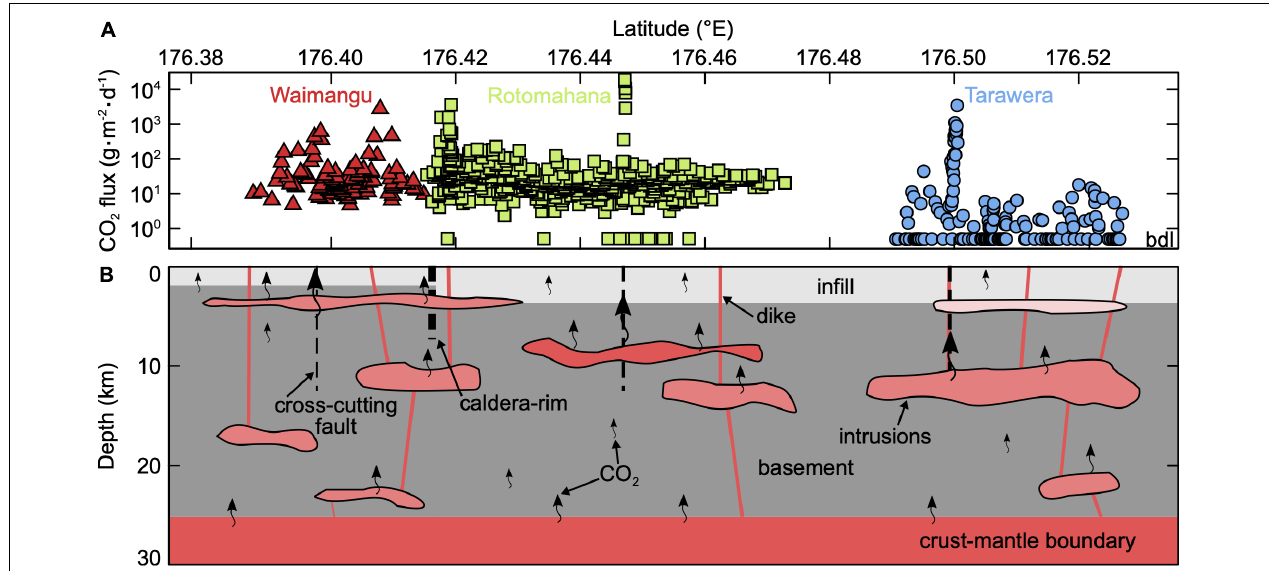
FIGURE 8 | (A) Raw CO 2 flux against latitude for Waimangu (red triangles) (Hurst et al., 2006), Rotomahana (green squares) (Mazot et al., 2014), and Tarawera (blue circles) (this study) where bdl is data below detection limit ( < 1 g · m − 2 · d − 1 CO 2 flux), and (B) a conceptual model of the sub-surface below the 1886 fissure, showing intrusions (pinks and reds) (approximate depths based on Bannister et al., 2004; Sable et al., 2009; Johnson et al., 2011; Cole et al., 2014; Heise et al., 2016, 2010), volcanic infill (light gray) (depths from Seebeck et al., 2010), basement (dark gray), crust-mantle boundary (red) (depth from Bannister et al., 2004), caldera-rim fault (thick, dashed, black line) (location based on Nairn, 2002), cross-cutting faults (thin, dashed, black lines) (locations based on this study), dikes (thin, pink, solid lines), and CO 2 degassing (curly arrows, where size indicates flux).